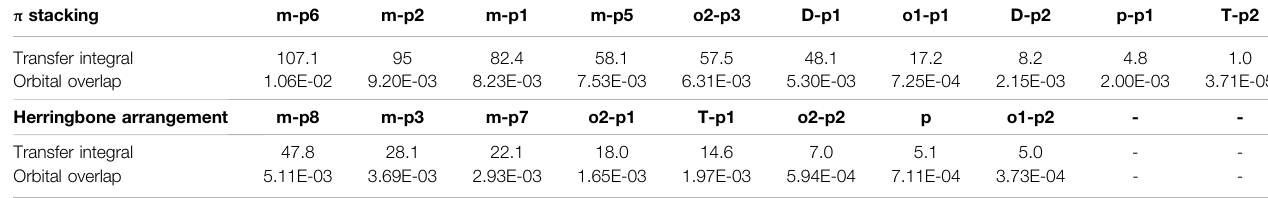
TABLE 3 | Transfer integral and orbital overlap integral of every primary hole pathways in π stacking and herringbone arrangement. π stacking